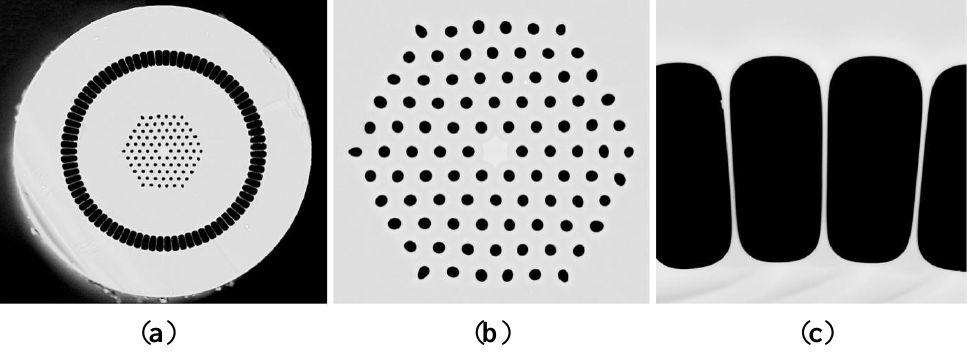
Figure 8. Cross-section of a manufactured double-clad photonic crystal fiber of the following dimensions: 285-μm outer diameter, 180-μm internal cladding (pump wave-guide) ( a ); 3.2-μm air holes, 11.5-μm core diameter, 8.5-μm diameter of the ytterbium-doped area ( b